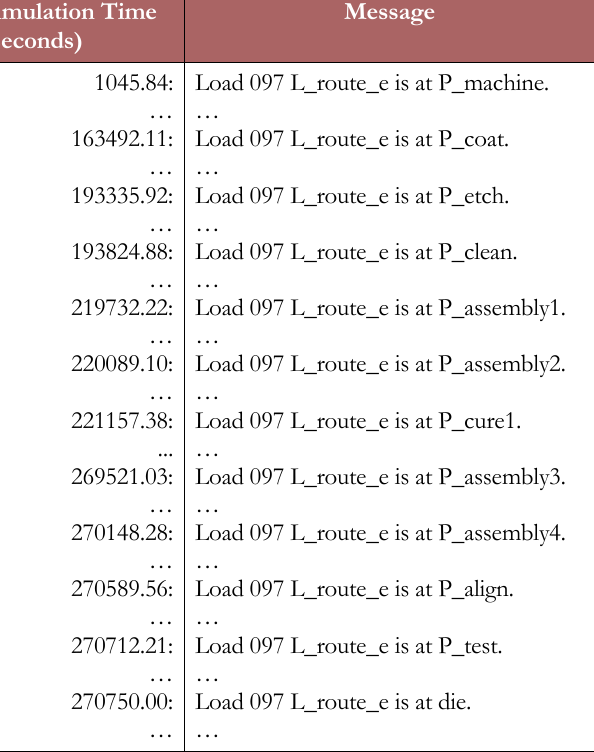
Table 5. Load Type Process Flow